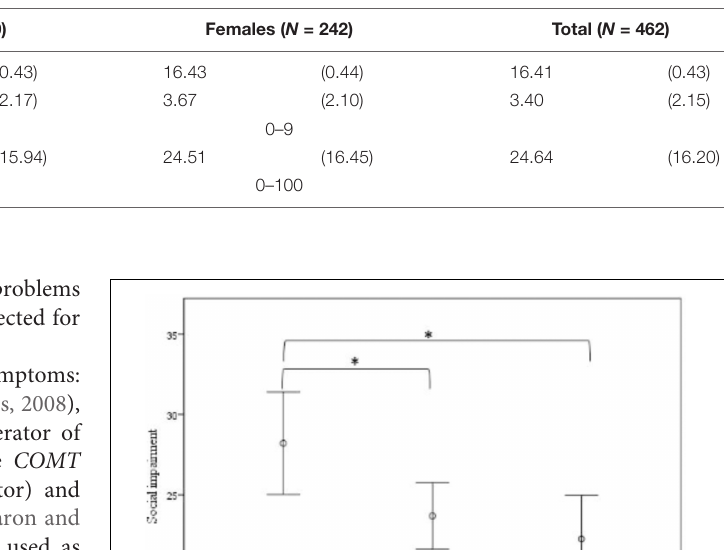
TABLE 2 | Sample characteristics for the whole group and separately for males and females.